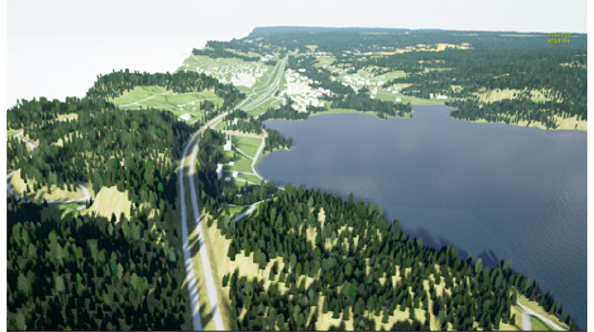
Figure 5 . Vegetation generated through the Procedural Mesh Generator. Bird’s-eye view